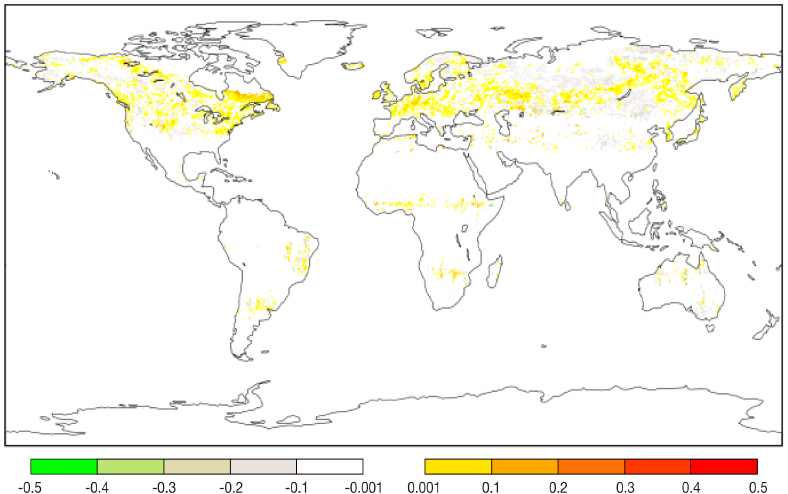
Figure 21. Difference of the surface soil moisture correlation with regards to the ESA-CCI surface soil moisture product between simulations using the 10-layer configuration and the current 4-layer configuration for